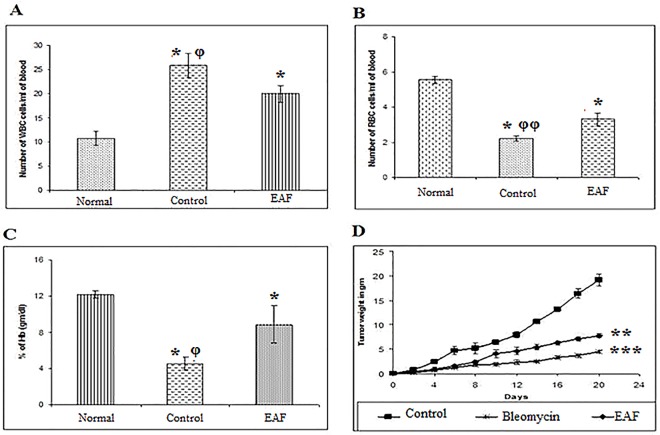
Differences in the hematological parameters of normal group (Group I: non tumor-bearing, which received vehicle only), untreated tumor-bearing control mice (Group II), and EAF-treated tumor-bearing mice (Group III) on day 12 after tumor inoculation.(A) White blood cell (WBC) count, (B) Red blood cell (RBC) count, (C) % of Hemoglobin (Hb). Significant differences of Group II and Group III was compared with Group I marked as asterisk and phi represents significant differences between Group III and Group II (*/φp < 0.05, **/ φ φp < 0.01, and ***/ φφφp < 0.001). Tumor weight differences (D) was measured and % of tumor weight was calculated compared to Group II, Group III, and Group IV (bleomycin-treated tumor-bearing mice) daily per mouse upto 20 days of treatment. Data are representative of three independent experiments (4 mice per group). Significant differences of Group III and Group IV was compared with Group II marked as asterisk (*p < 0.05, **p < 0.01, and ***p < 0.001).